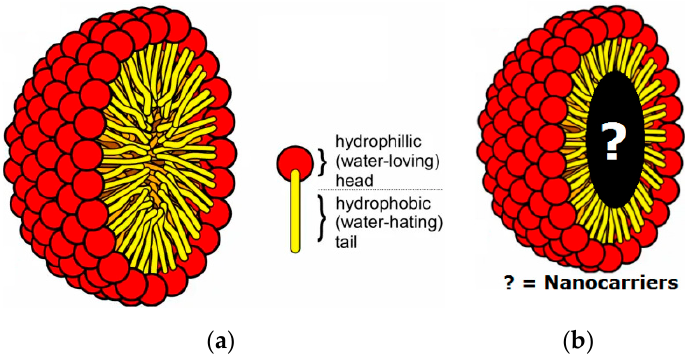
Figure 6. Structure of ( a ) micelle and ( b ) encapsulated nano ‐ carriers.